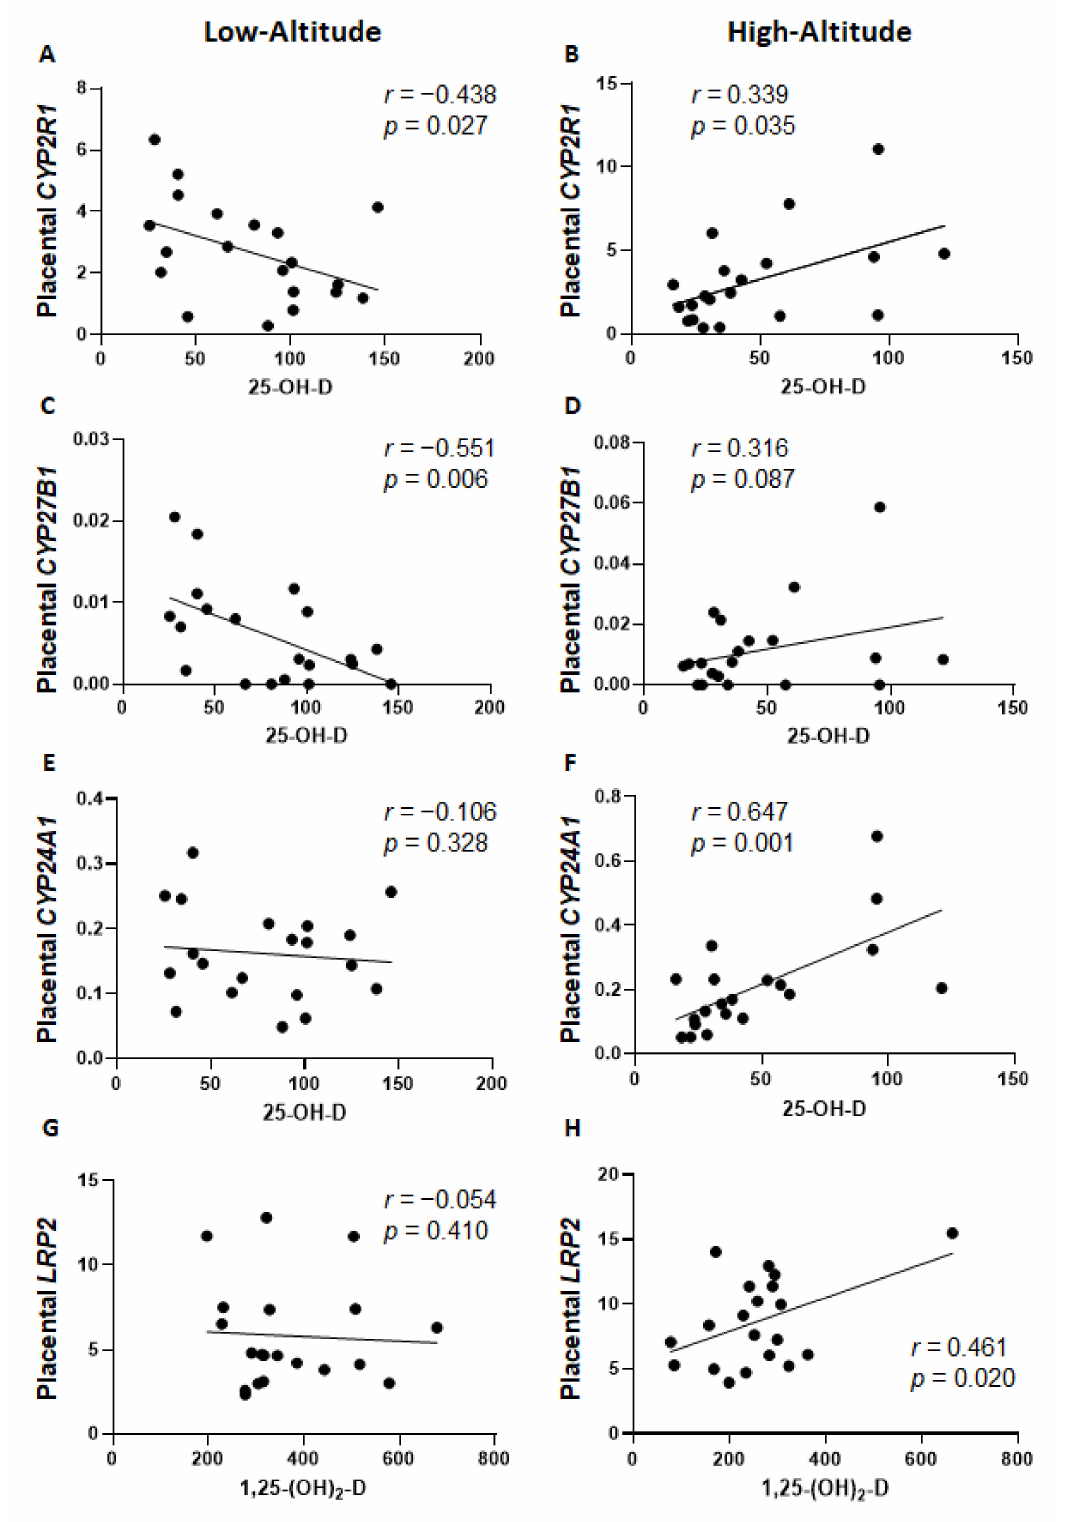
Figure 3. Correlation between vitamin D levels and placental gene expression. Linear regression analysis shows the association in low-altitude residing subjects ( n = 20, ( A – D )) or high-altitude residing subjects ( n = 20, ( E – H )). ( A , B ) correlation between maternal 25-OH-D and placental CYP2R1 , ( C , D ) maternal 25-OH-D and CYP27B1 , ( E , F ) maternal 25-OH-D and CYP24A1 , and ( G , H ) maternal 1 α ,25-(OH) 2 -D and LRP2 . Insets show the correlation coefficient and p